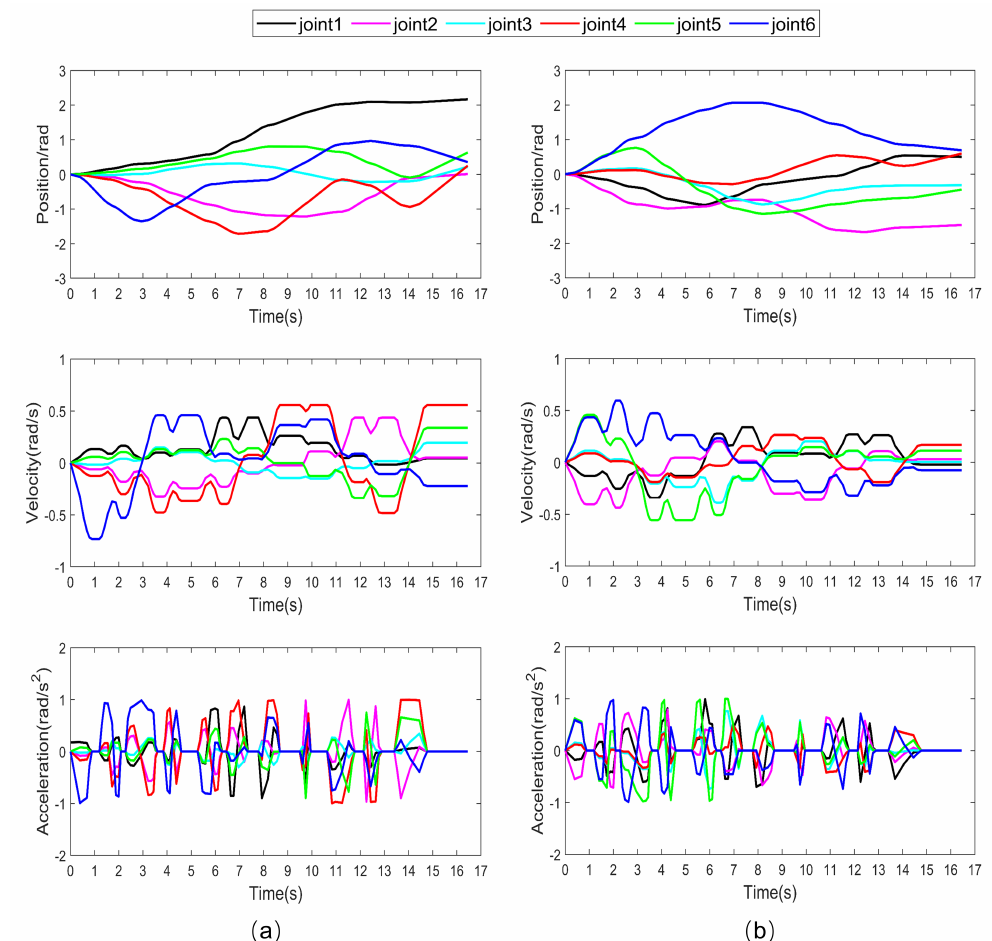
Figure 12. Position-velocity-acceleration curve of each dual-robot joint. ( a ) Joint 1–6 of left robot. ( b ) Joint 1–6 of right robot.